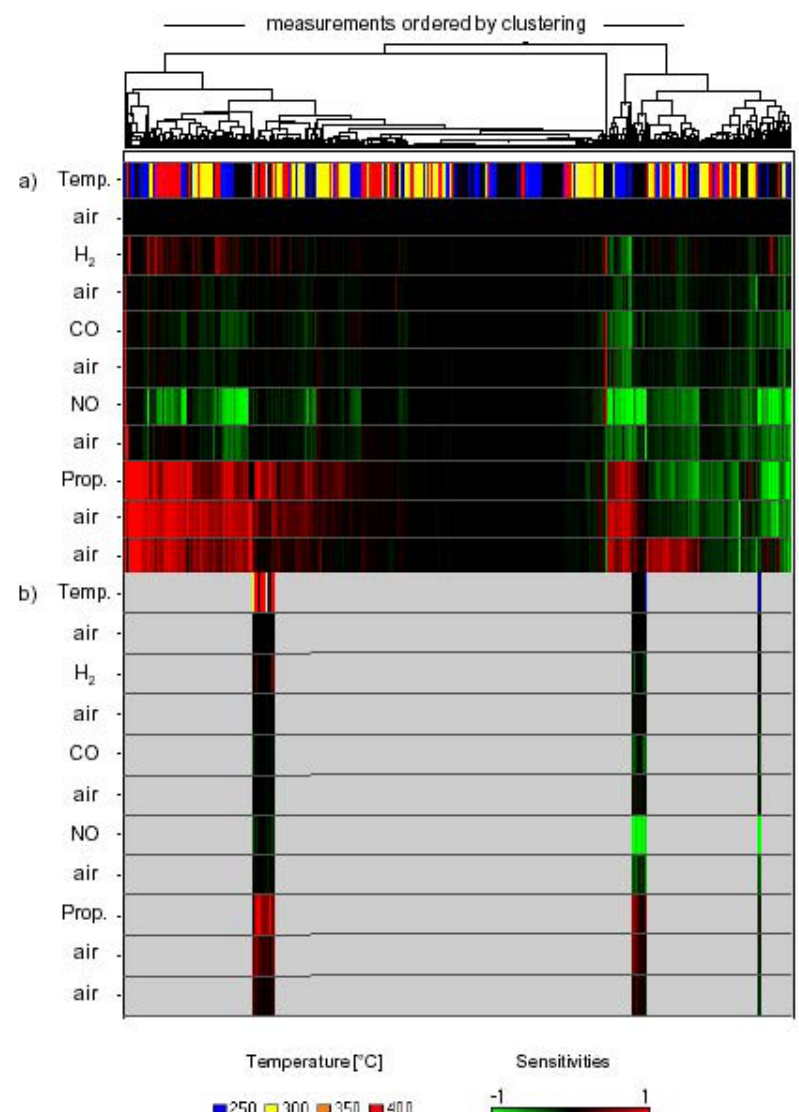
Figure 8. a) Hierarchical clustering map of the sensitivities based on the high-throughput constant current measurements using the data-mining software Spotfire ™ . Clustering algorithm: ’Complete Linkage’ of the Euclidean distances. b) Cluster of high selective sensors towards NO or propene respectively extracted from